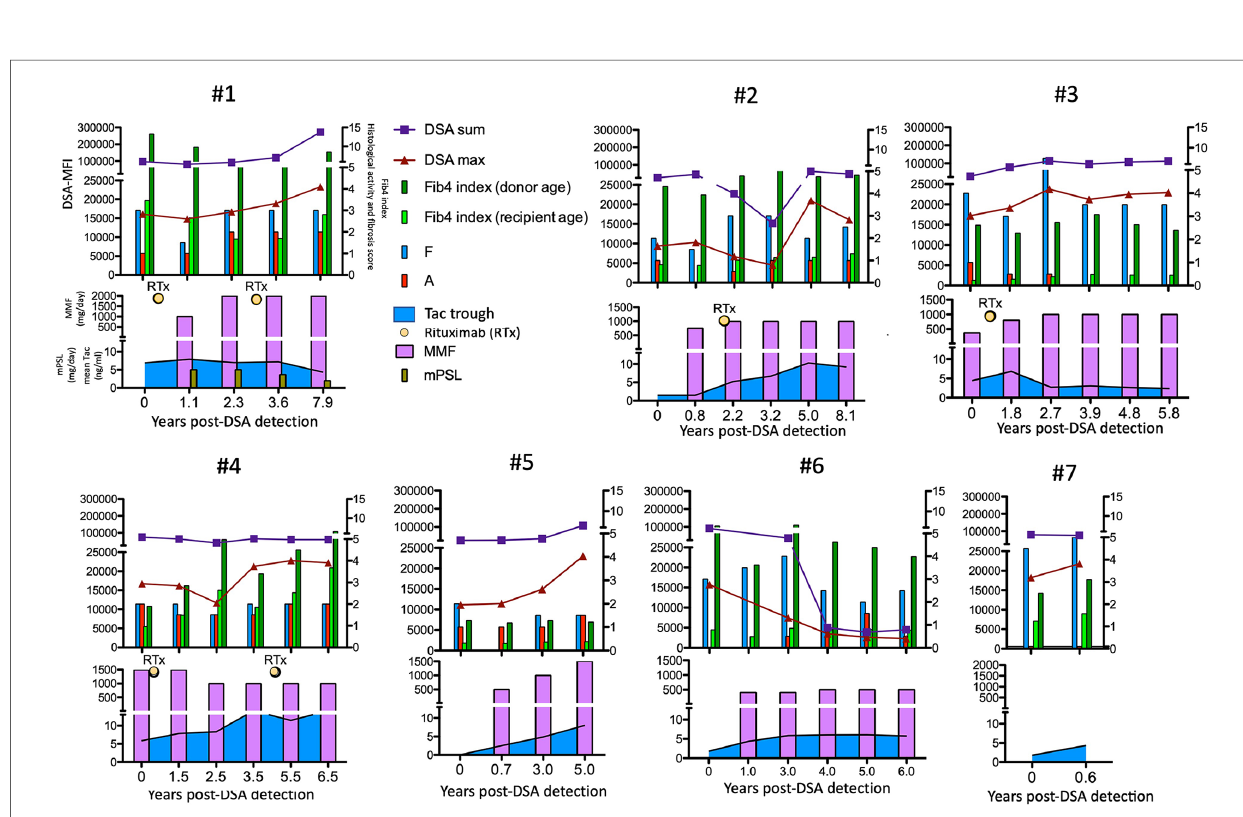
FIGURE 6 The time courses of the maximum (red triangles) and sum (blue squares) of the DSA-MFI, Fib-4 indexes calculated by ages of the recipient (fresh green bar) and donor (green bar), histological evaluations by liver biopsies (F, fi brosis score and A, METAVIR activity score) and immunosuppressants among seven patients in the high-risk group. RTx, rituximab. Tac,